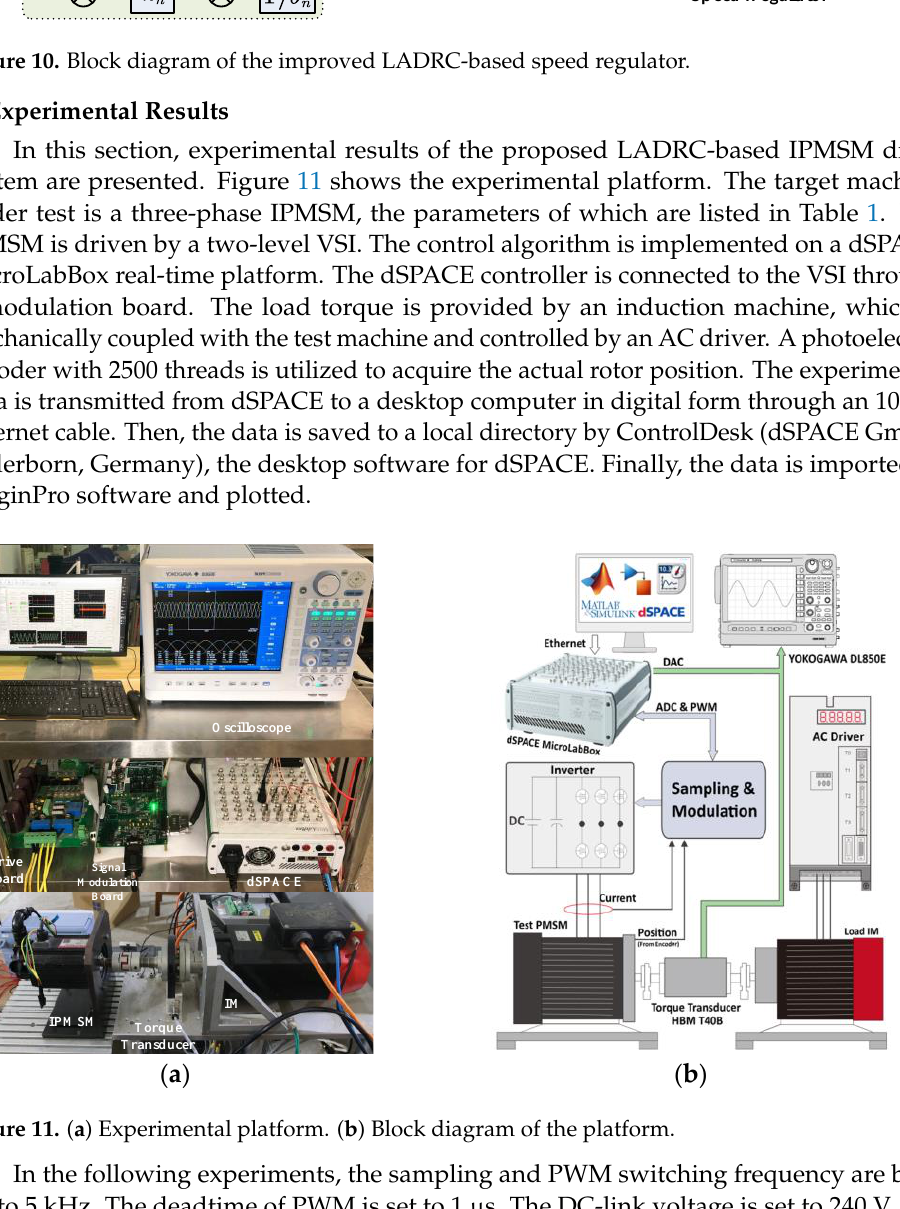
Figure 11. ( a ) Experimental platform. ( b ) Block diagram of the platform.